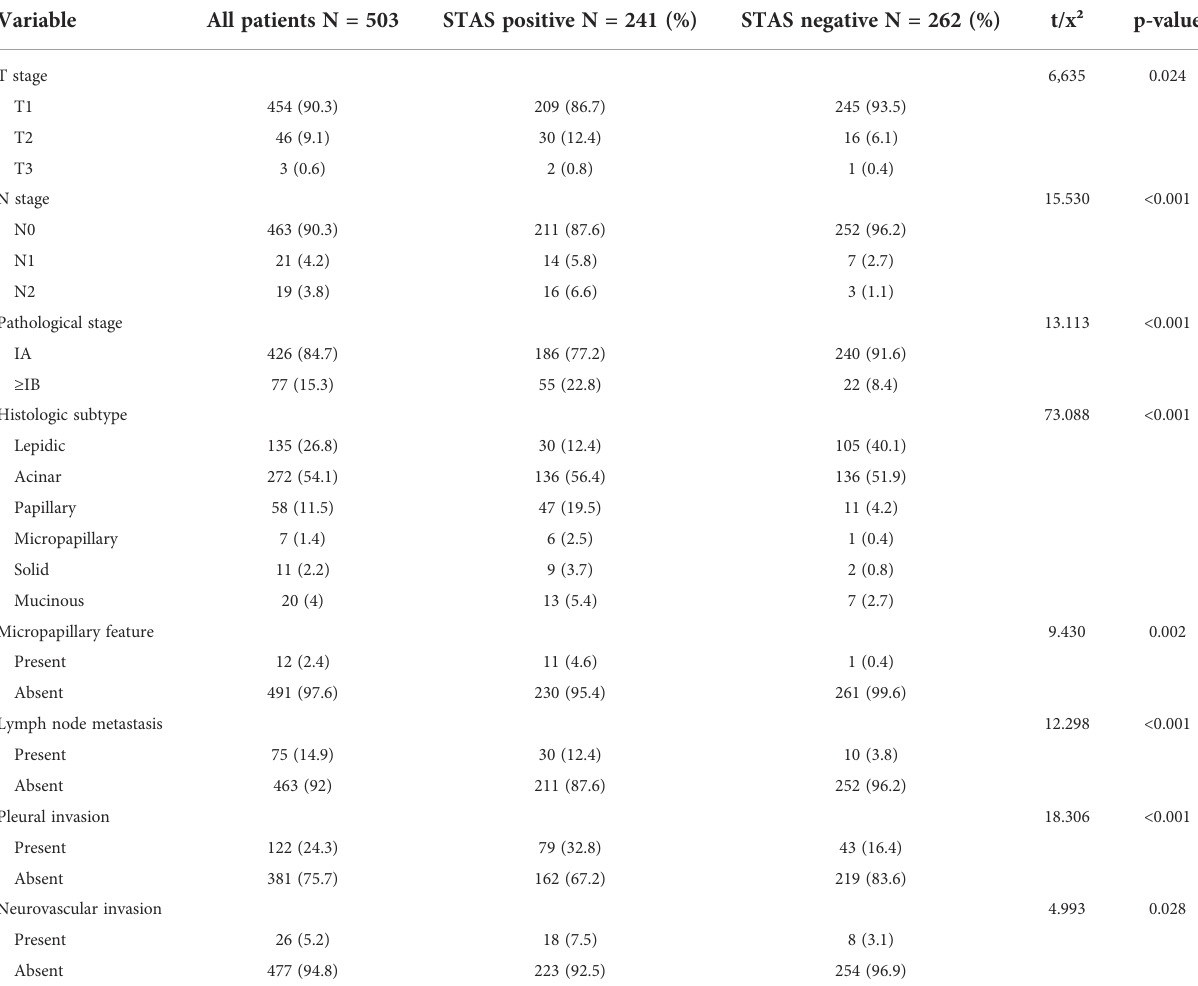
TABLE 2 Association between STAS and pathological characteristics (n